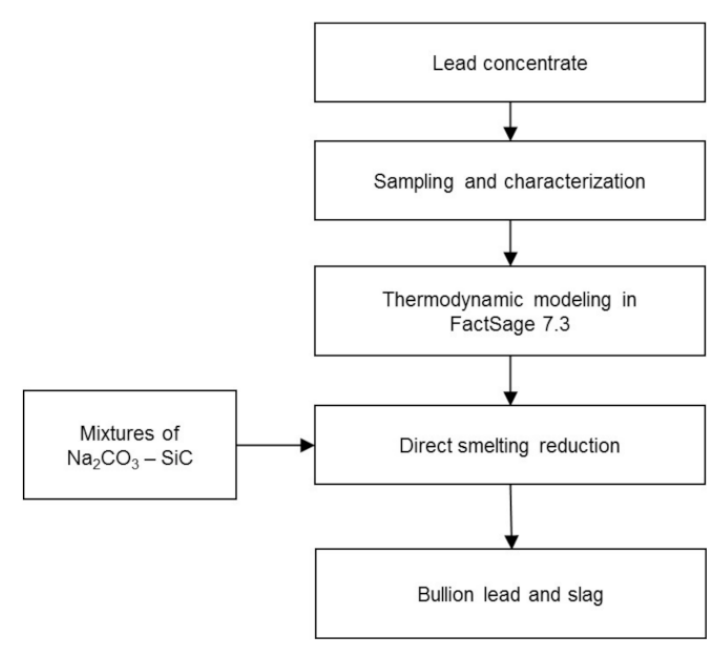
Figure 2. Flow chart for lead recovery from a lead concentrate with mixtures of Na 2 CO 3 and SiC to 1000 ◦